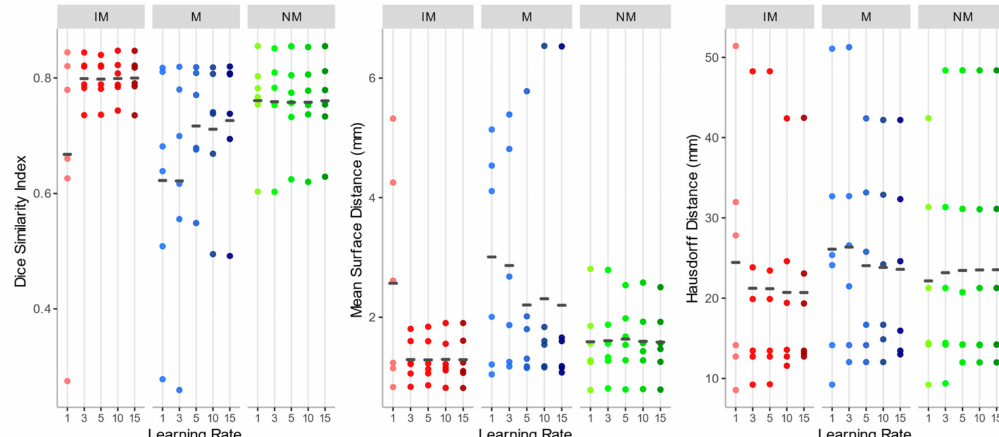
Figure 5. Dice similarity index (DSI), mean surface distance (MSD), and Hausdor ff distance (HD) values of the isotropic voxels with mask (IM), native resolution with mask (M), native resolution without selecting a mask (NM) rigid registration schemes. The accuracy indexes were evaluated considering the 4 muscle ROIs